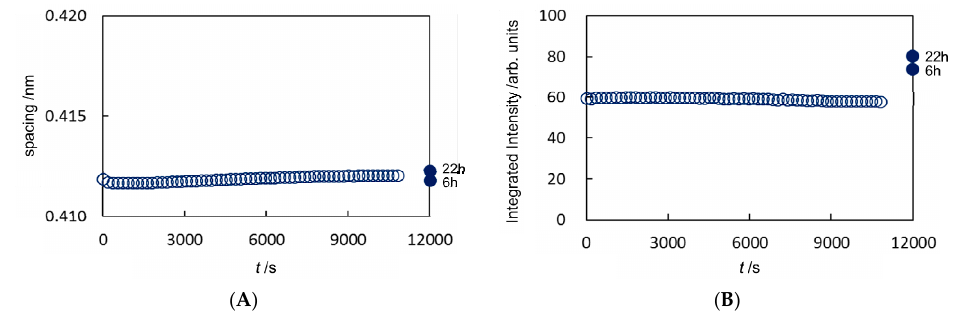
Figure 2. Analyzed results in the stratum corneum treated with ethanol for sample #E1. ( A ) Change of the spacing of the hydrocarbon-chain packing structure at the lattice constant 0.41 nm and ( B ) the change in its integrated intensity. The data denoted on the time scale at 12,000 s for convenience were those obtained by removing ethanol from the treated stratum corneum for 6 h and 22 h (hereafter the similar expression is adopted).